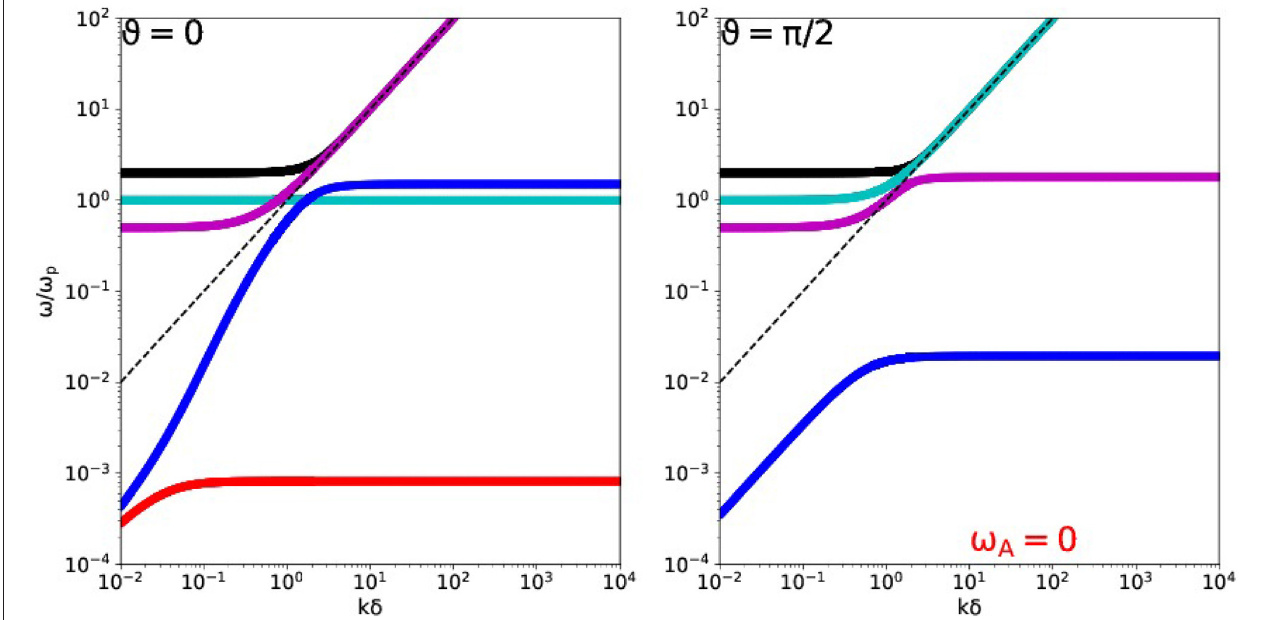
FIGURE 2 | Dispersion diagram for a hydrogen ion-electron plasma at E The dashed black line corresponds to light speed behavior.